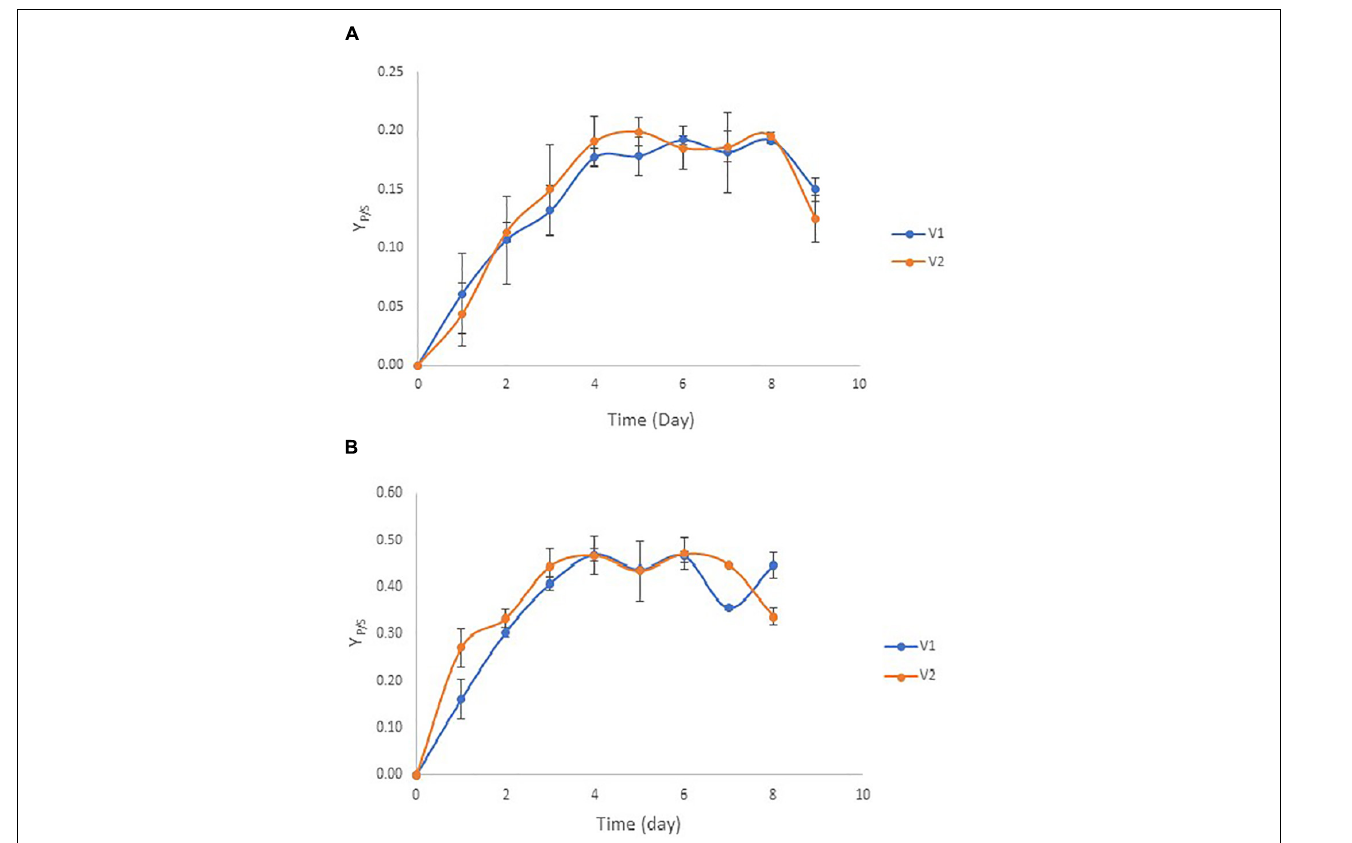
FIGURE 4 | Ethanol yield (Y P / S ) by biofilms of Z. mobilis strains ZM4 (A) and TISTR 551 (B) in multi-chamber biofilm reactors (V1 and V2) at the optimum dilution rate using rice straw hydrolysate as a substrate.